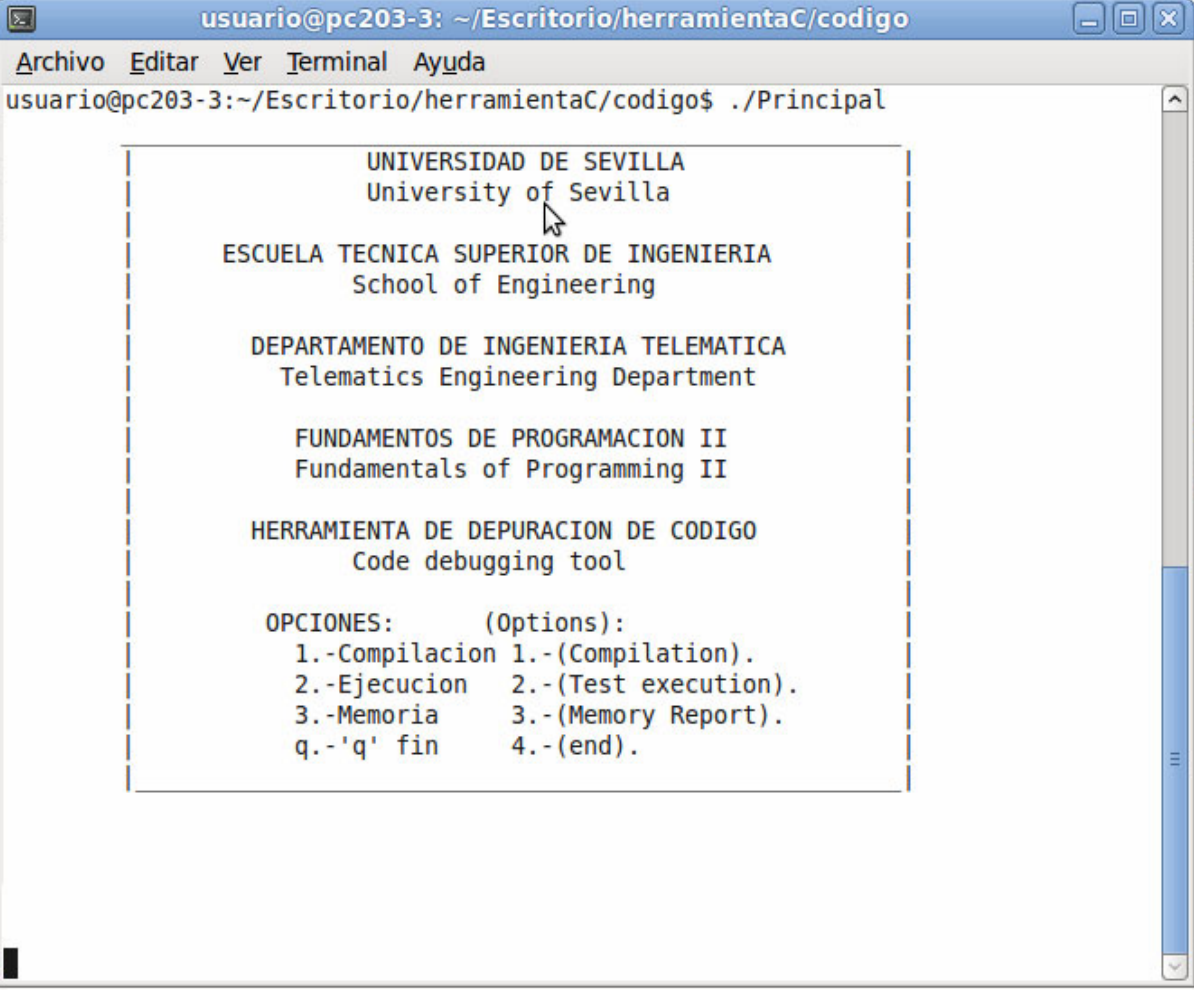
Figure 2. User interface of the tool.